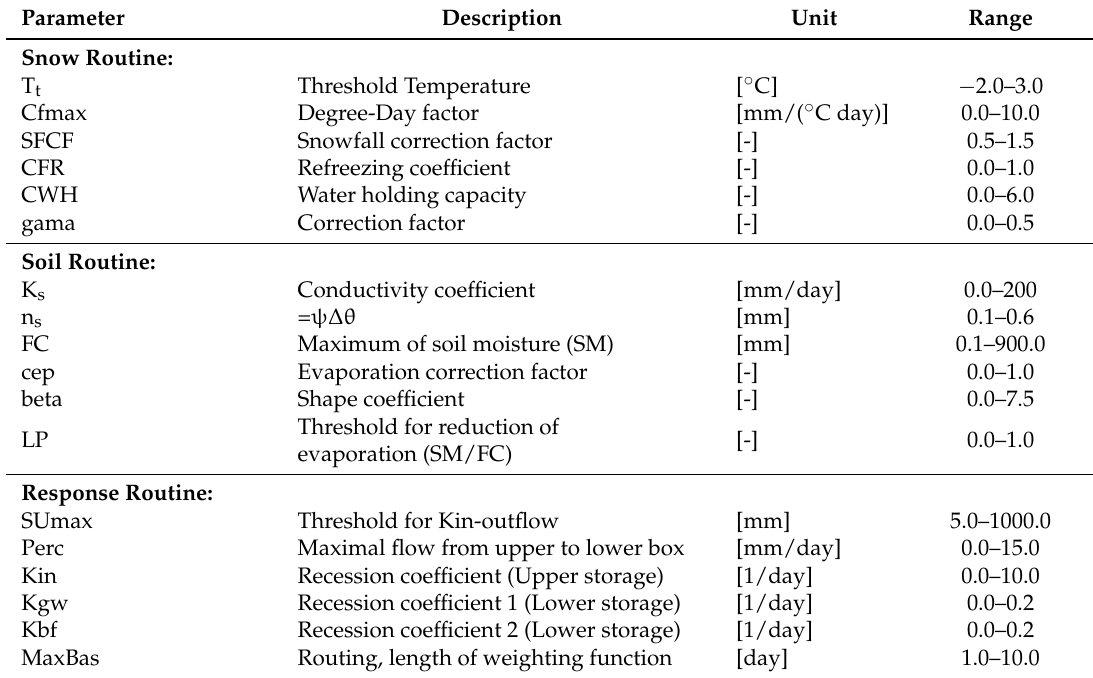
Table 1. The parameters of IHBV